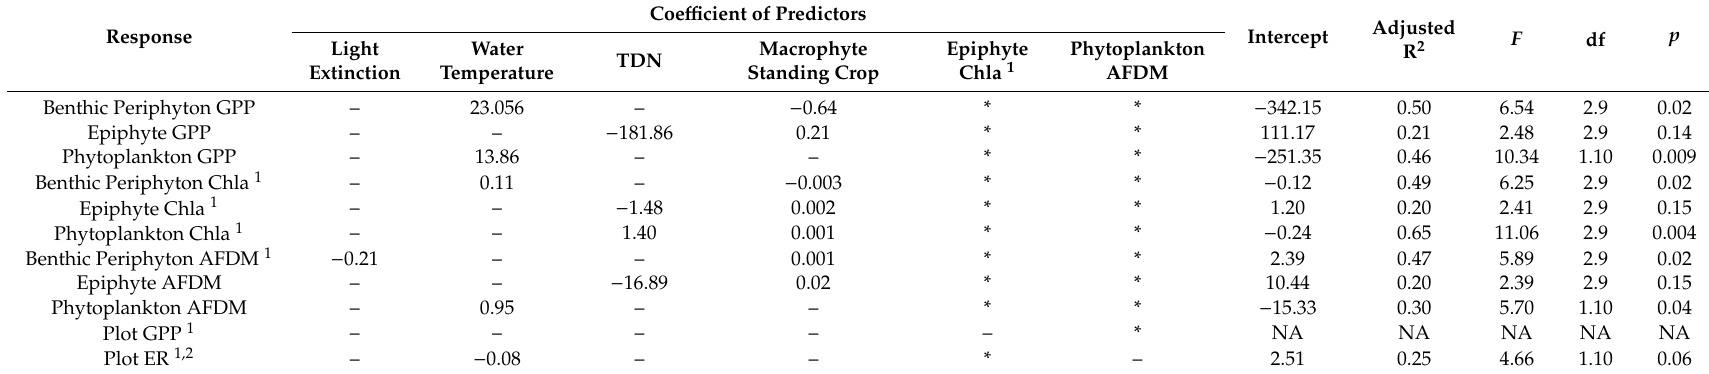
Table 4. Stepwise multiple linear regression models selected for responses of primary producers across all plots. Best models were selected for fit and parsimony by examining Akaike information criterion (AIC)